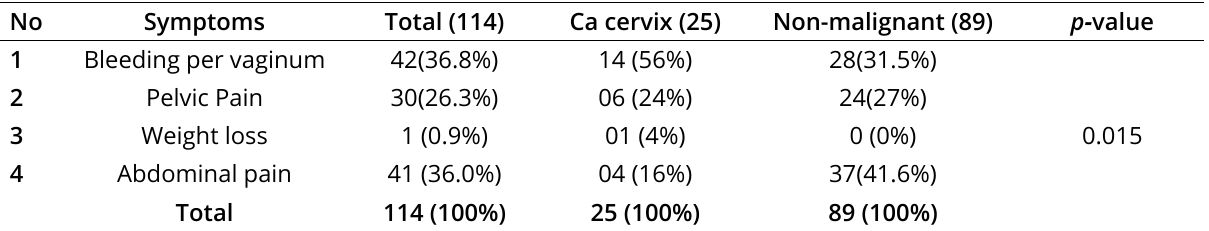
Table 1. Clinical